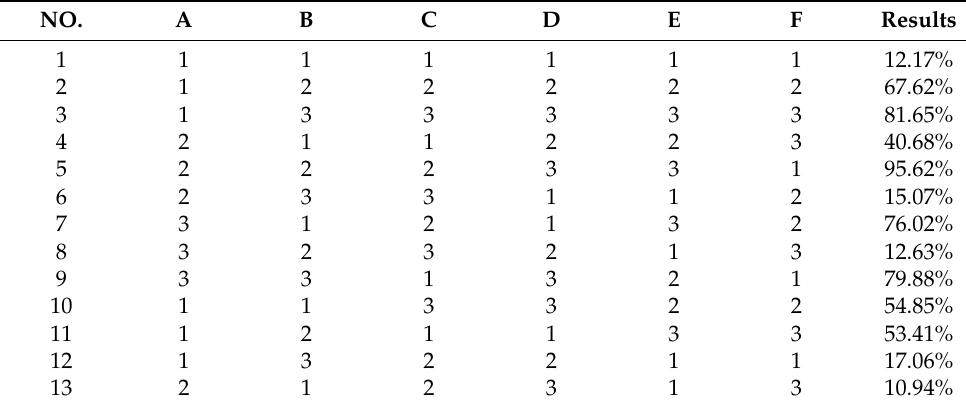
Table 5. Arrangement and results of the orthogonal